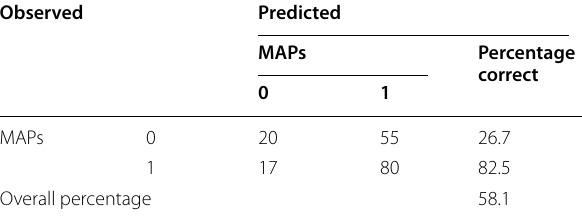
Table C: Classification table for innovation